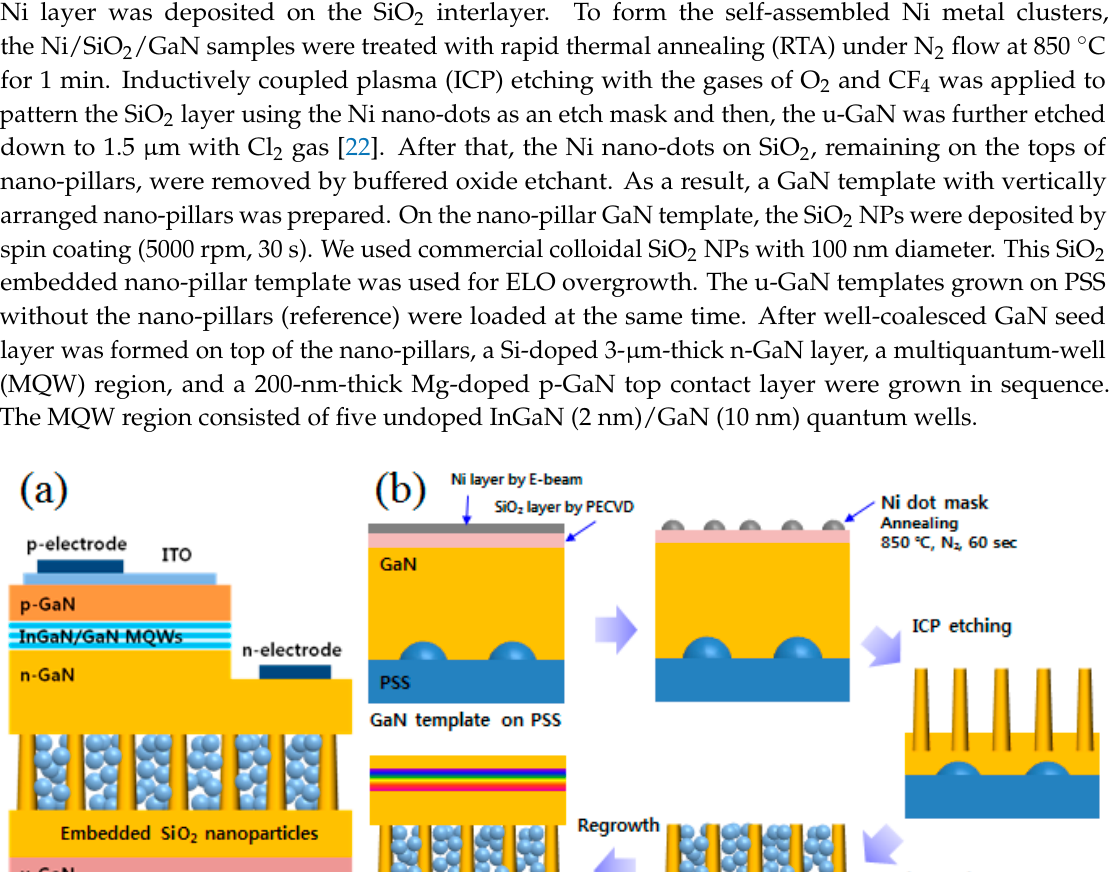
Figure 2. ( a ) Tilted field emission scanning electron microscopy (FE ‐ SEM) image of the SiO 2 nano ‐ particles (NPs) among nano ‐ pillars. ( b ) Zoomed ‐ in image to show the NPs clearly in air ‐ void. ( c ) FE ‐ SEM image of cross ‐ section of the regrown GaN layer with air ‐ voids and nano ‐ pillars. ( d ) Close ‐ up image of cross ‐ section of revealed SiO 2 NPs filling the air ‐ voids on the left. Figure 3 shows the performances of SiO 2 NP LED compared to the reference LED. When 20 mA current is injected into the SiO 2 NP LED and the reference LED, forward voltage is 2.84 V and 2.97 V, respectively (Figure 3a). The decrease of the forward voltage is considered as the result of the series resistance decrease caused by the TD decrease. This decrease in TD density comes in addition to the decrease of TD density produced by growth on the PSS which presents both in the reference and modified LED structures. From this perspective, the nano ‐ pillar layer overcomes disadvantages of